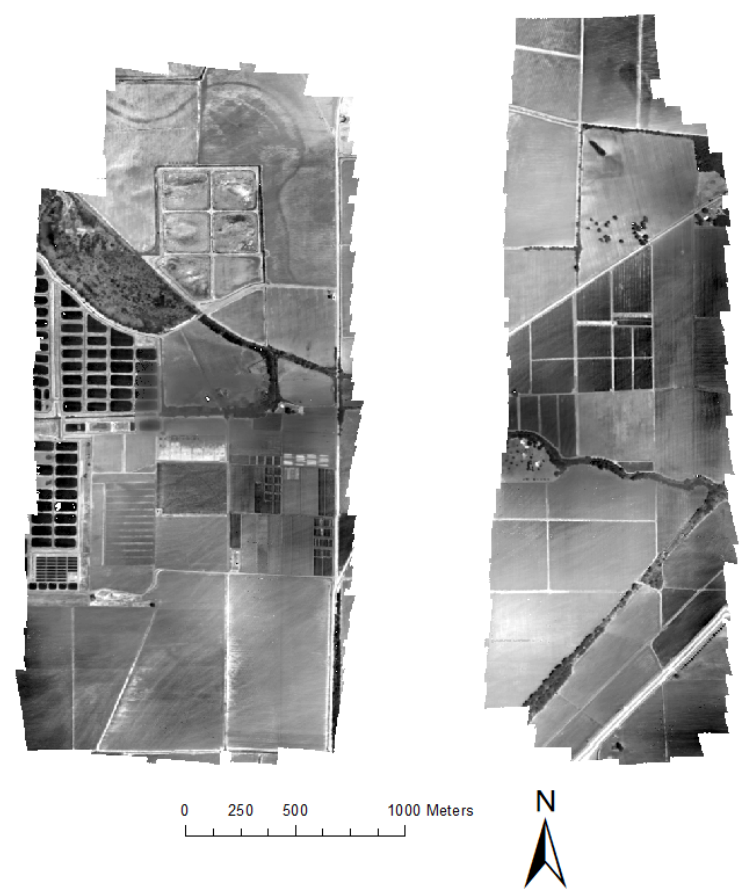
Figure 3. Orthomosaic thermal image (25 May 2017) of the research farm area at Stoneville,